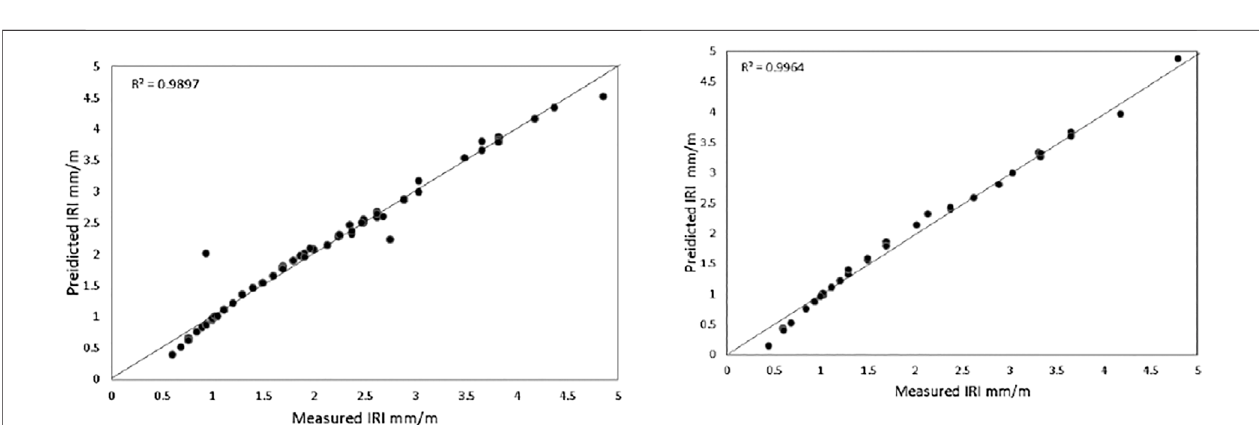
FIGURE 7 | Correlation scheme of predicted IRI against IRI for training and testing data.